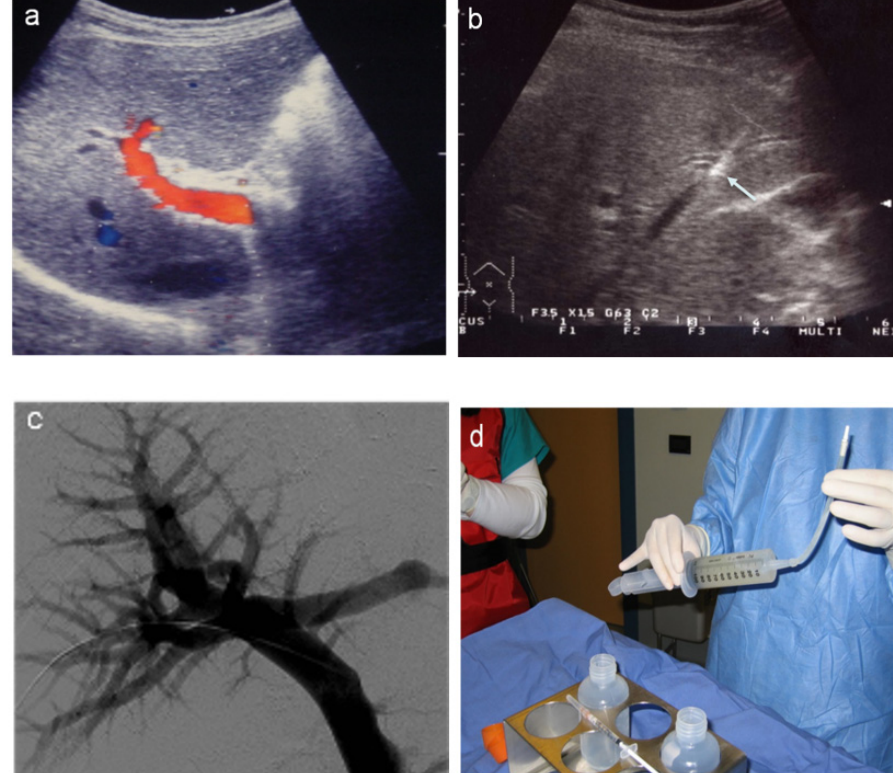
Figure 7. Percutaneous intra-portal islet auto-transplantation. ( a ) One day after extensive pancreatectomy, preliminary color Doppler examination showing portal vein patency. ( b ) Real-time, US-guided peripheral portal vein puncture (arrow). ( c ) After fluoroscopy-guided portal vein catheterization, preliminary portography, ( d ) before islet infusion.